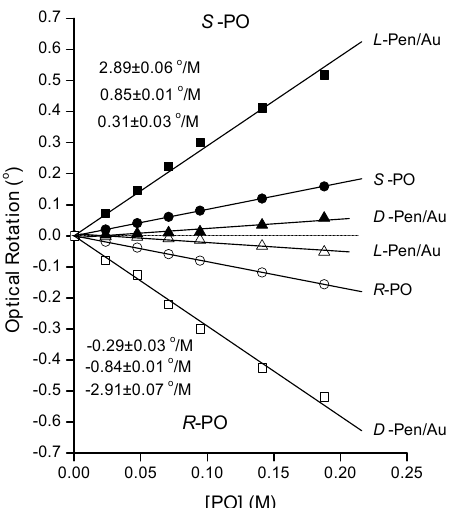
Figure 4. Optical rotation versus concentration of enantiomerically pure R- or S-PO in water and in solutions containing L- or D-Pen/Au-NPs. In aqueous solution, (● and ○ ), pure R- and S-PO rotate light with a specific rotation of ±0.85 ± 0.01 °/M. In the presence of L- or D-Pen/Au-NPs, the optical rotation for S-PO changes from 2.9 to 0.3 °/M. The concentration of Au was 0.24 M and the concentration of Pen was 0.025 M.